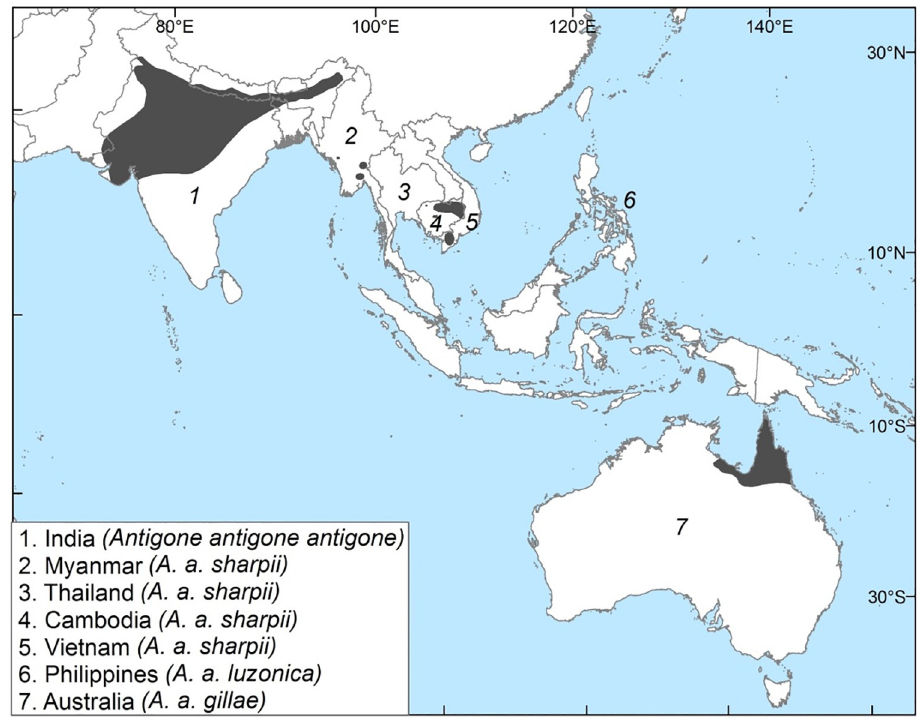
Fig 1. Global distribution of the Sarus Crane A . antigone , showing populations and subspecies [Distribution data derived from BirdLife International and NatureServe Bird Species Distribution Maps of the World [80], the Australian Bird Guide [81] and author contributions].